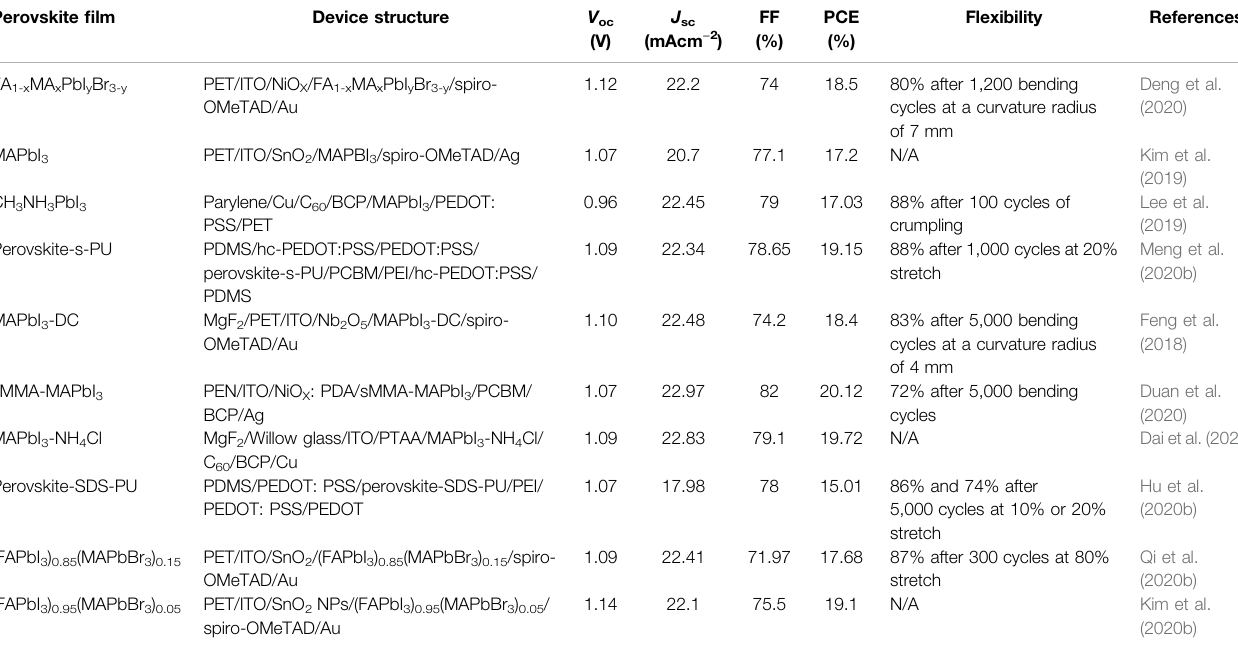
TABLE 2 | Summary of the photovoltaic and fl exibility performance of a high-quality perovskite fi lm. Perovskite fi